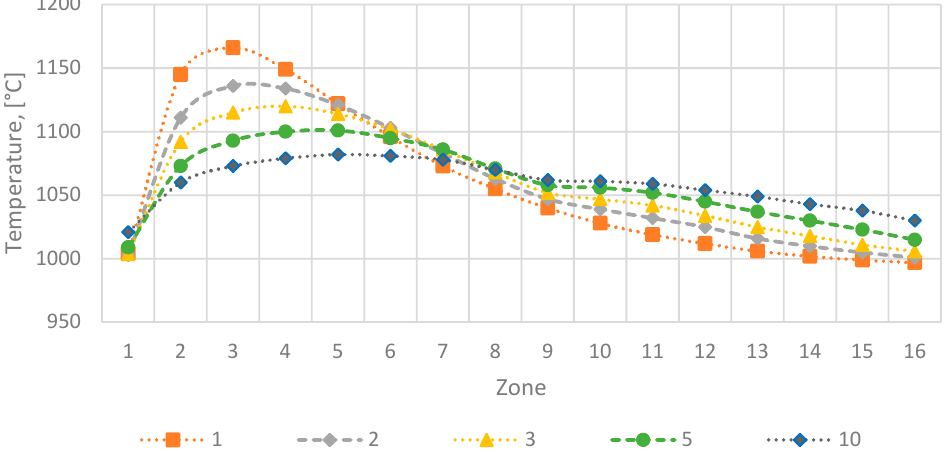
Figure 9. Temperature distribution over the zones of the furnace with variable rate of recirculation of furnace gases with minimum thermal power.